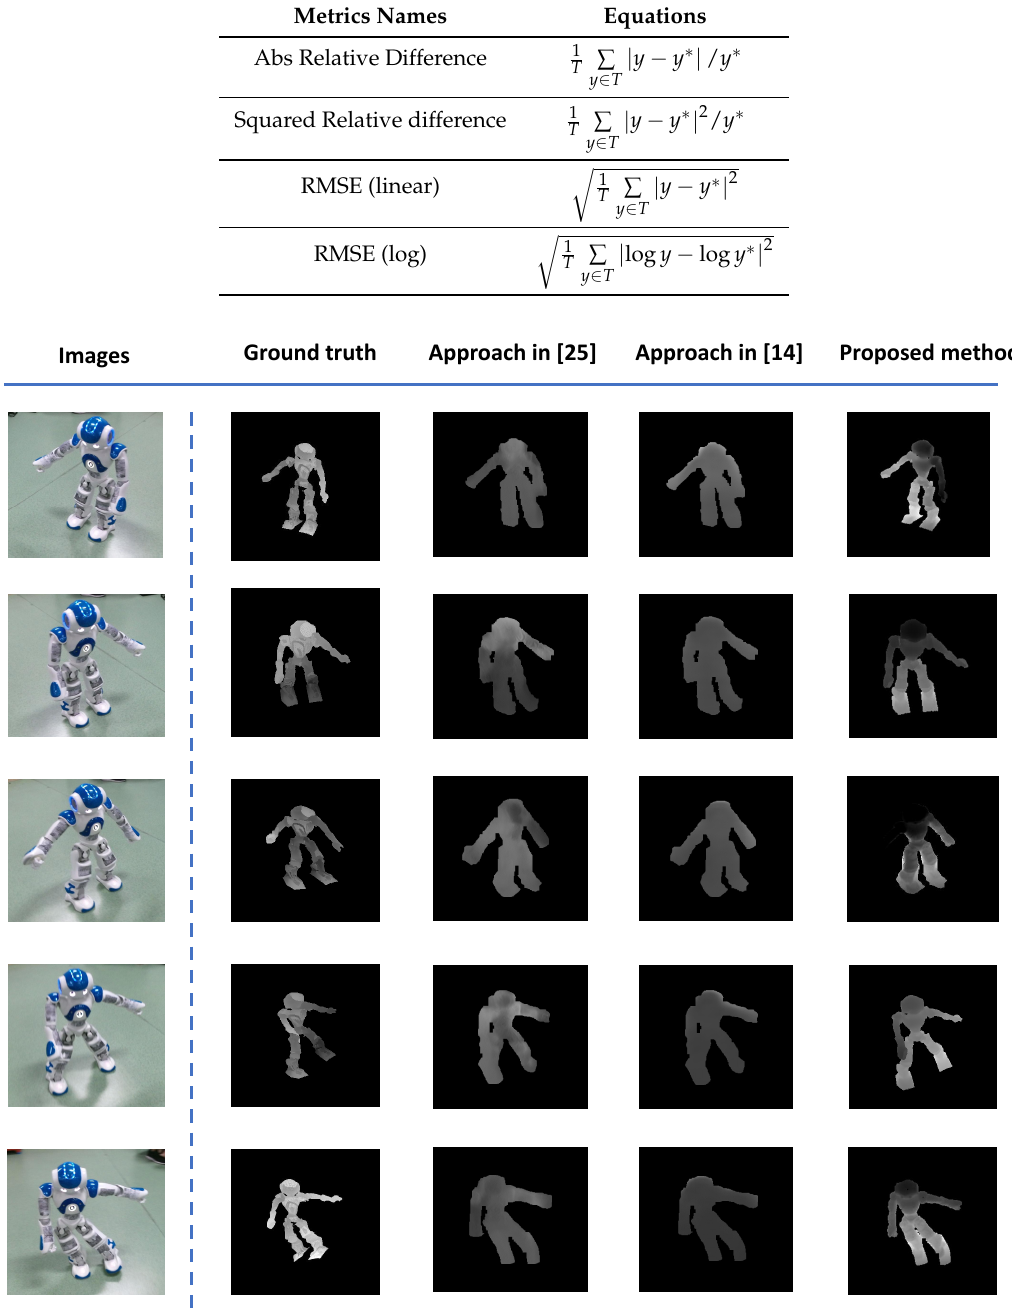
Table 1. Quantitative comparison on the aspects of accuracy and efficiency.